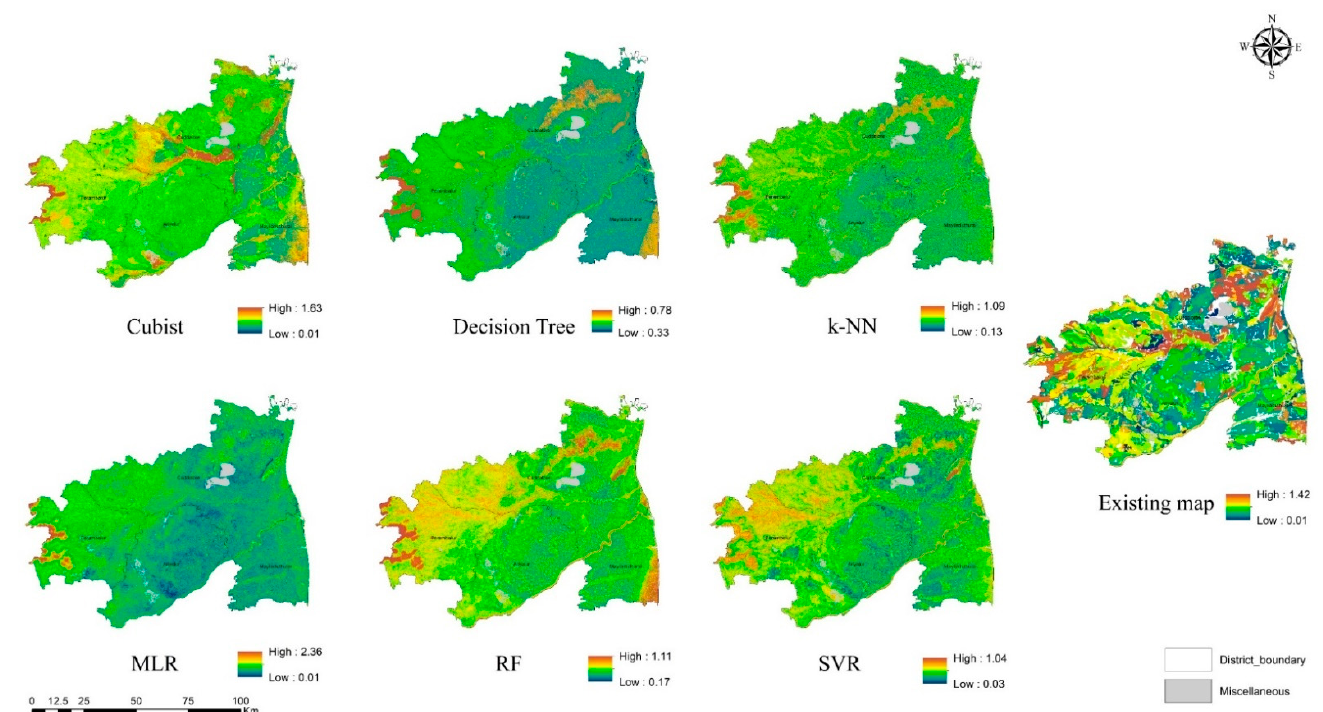
Figure 4. Existing and predicted maps of CEC using different machine learning algorithms.